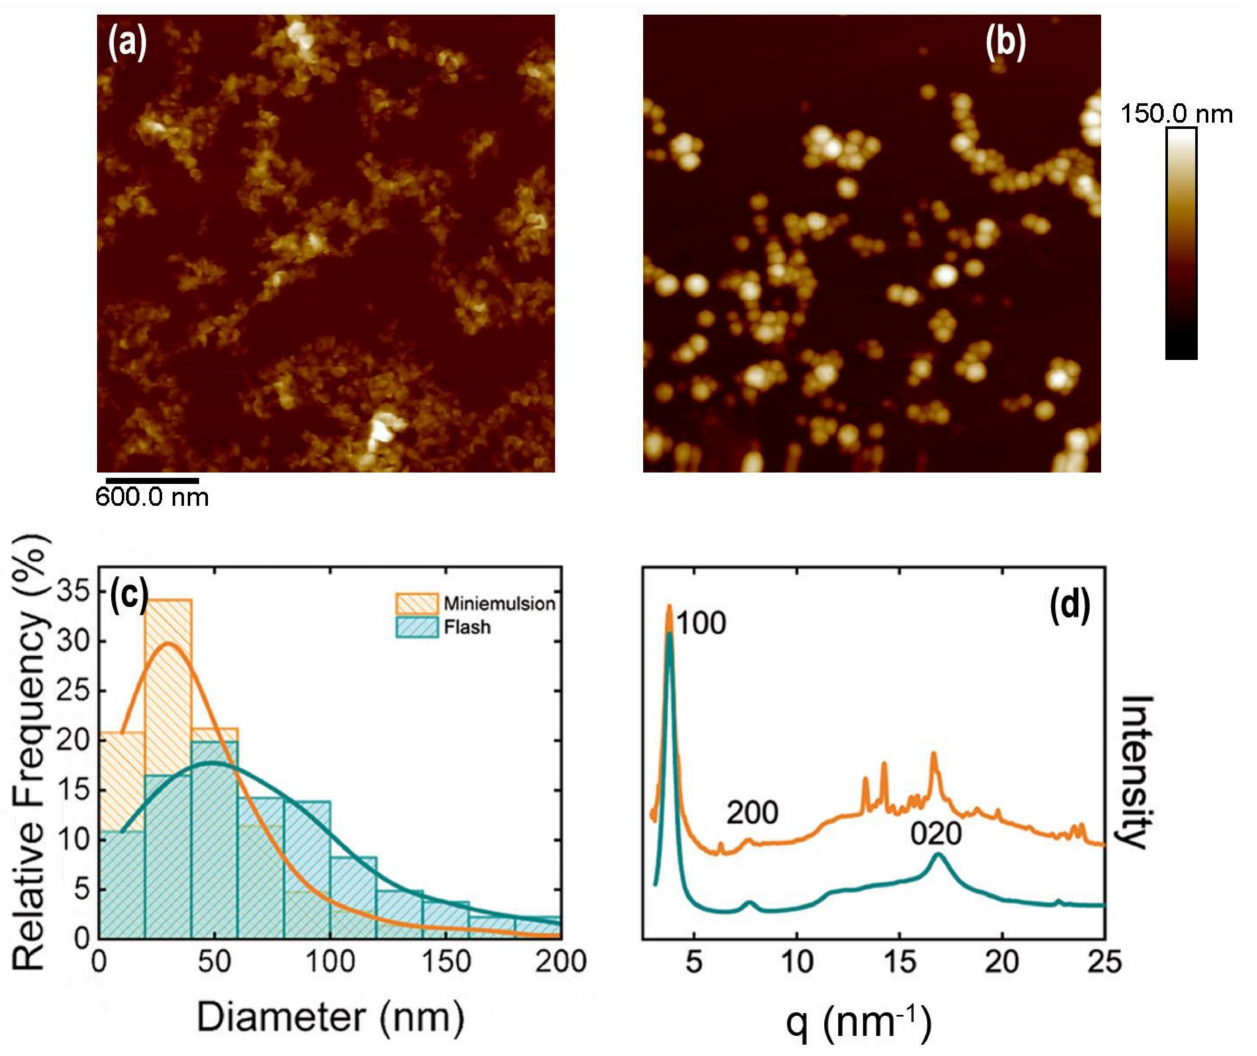
Figure 3. Morphology of spin-coated miniemulsion ( a ) and flash ( b ) P3HT inks onto silicon wafers, observed by AFM; ( c ) size distribution of the observed nanoparticles; ( d ) X-ray diffraction profile of both types of P3HT